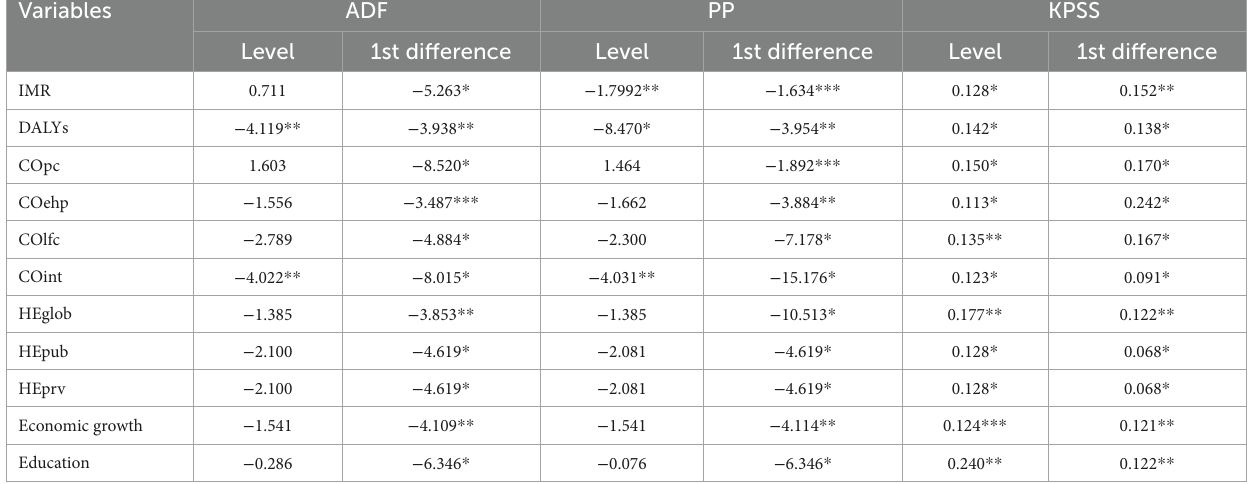
TABLE 2 Results of unit root